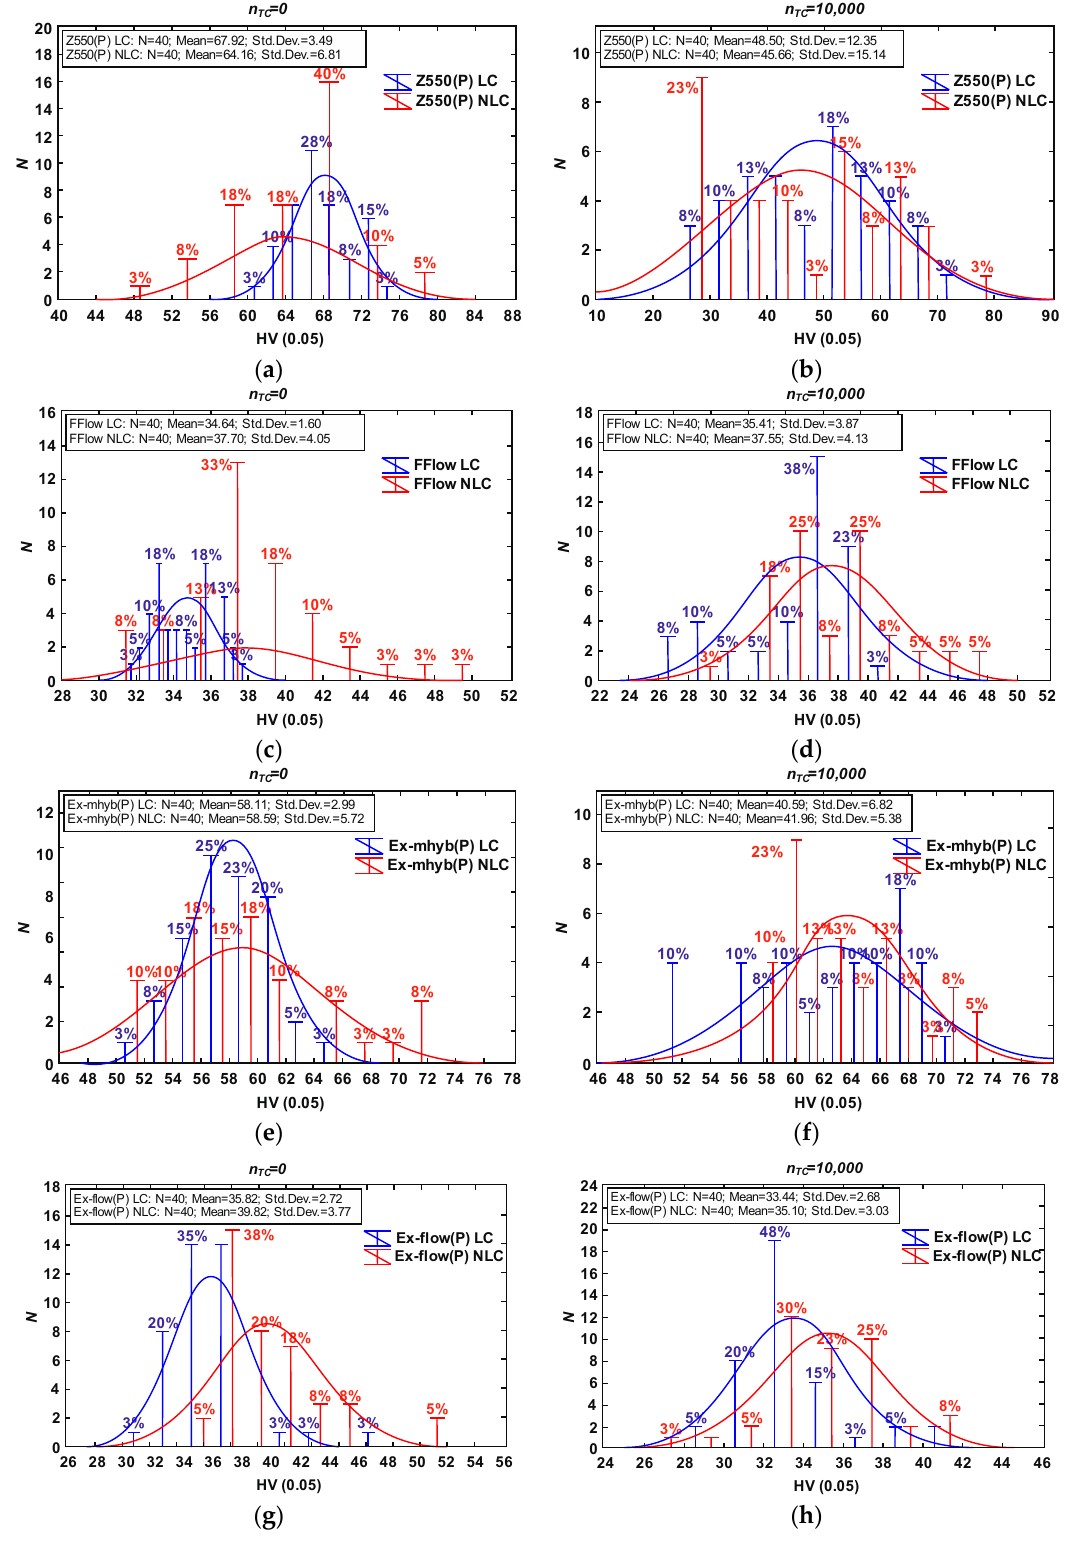
Figure 2. Vickers hardness results due to material type and thermocycling fatigue: Z550 composite ( a ) only aging in artificial saliva (AS), ( b ) after thermocycling (TC); FFlow composite ( c ) only aging in AS, ( d ) after TC; Ex-mhyb (P) composite ( e ) only aging in AS, ( f ) after TC; Ex-flow (P) composite ( g ) only aging in AS, ( h ) after TC. The Vickers hardness diagrams are given in units characteristic for method (HV). Table 1. Shapiro–Wilk test values for normal distribution for Vickers hardness results. Values of 𝑝 < 0.05 are marked in red.